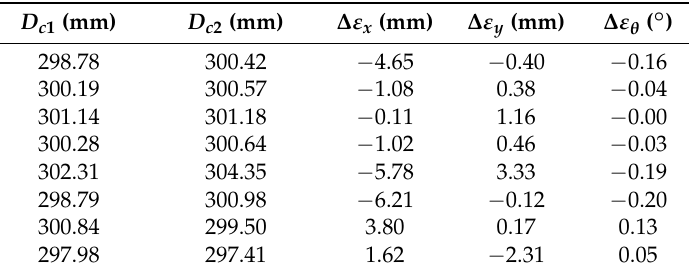
Table 1. The localization data of the robot.